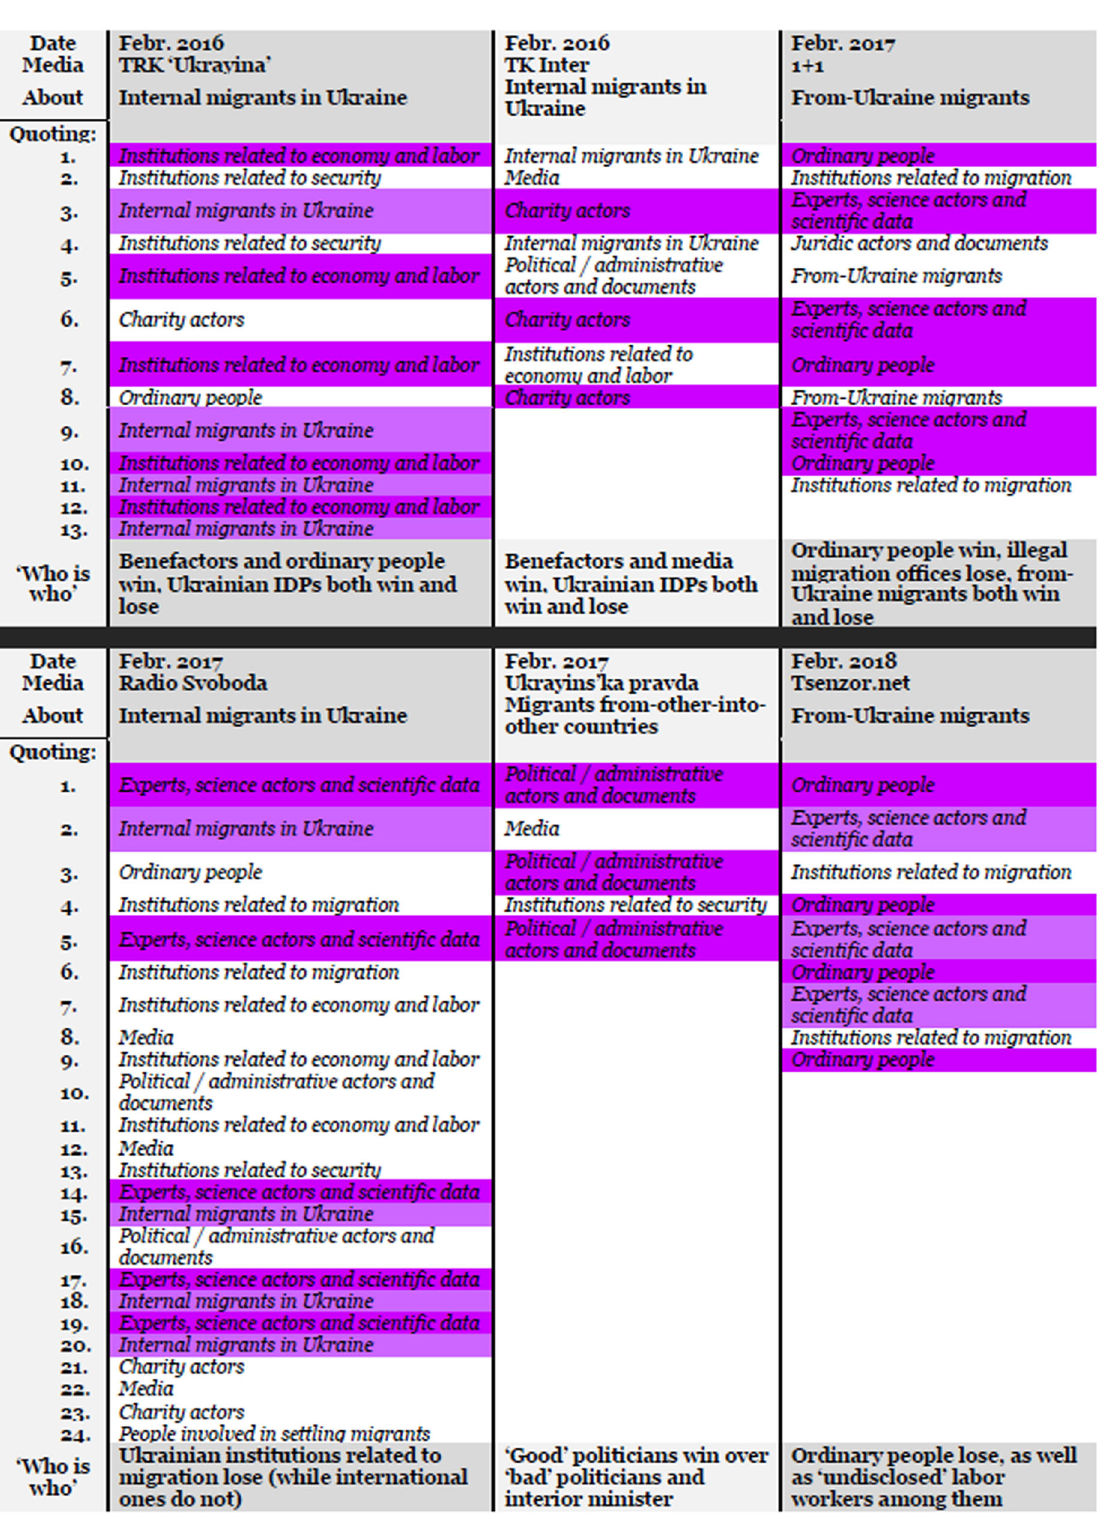
HUMANITIES AND SOCIAL SCIENCES COMMUNICATIONS| (2021) 8:289